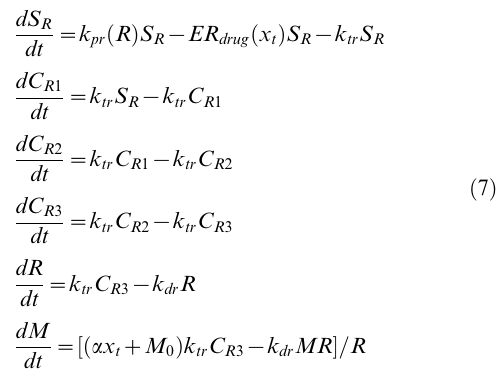
6-MP Model (Variable for GSA: x t ) Parameters